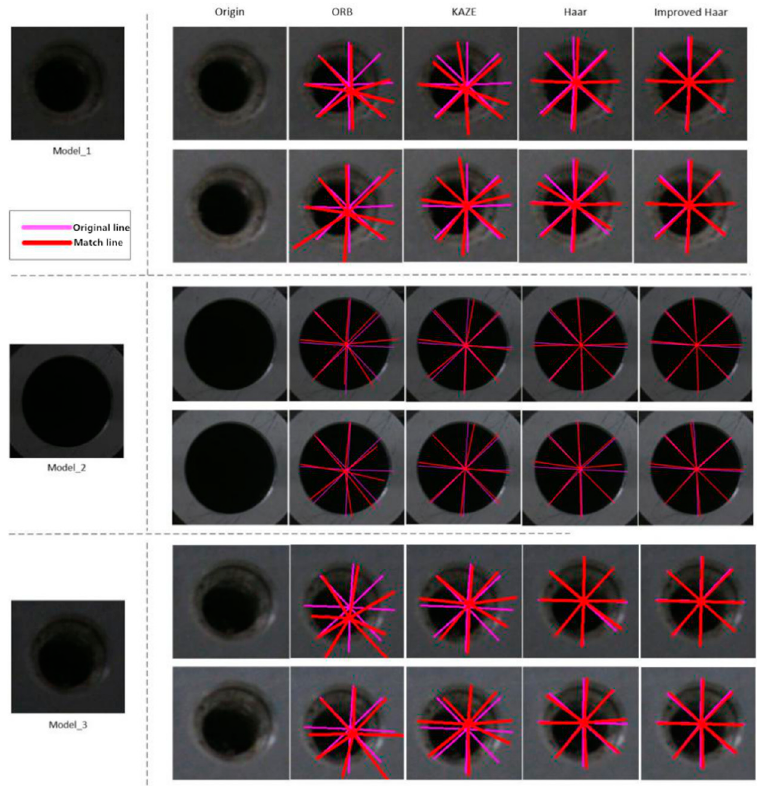
Figure 9. Matching results of different illumination images by four matching algorithms.